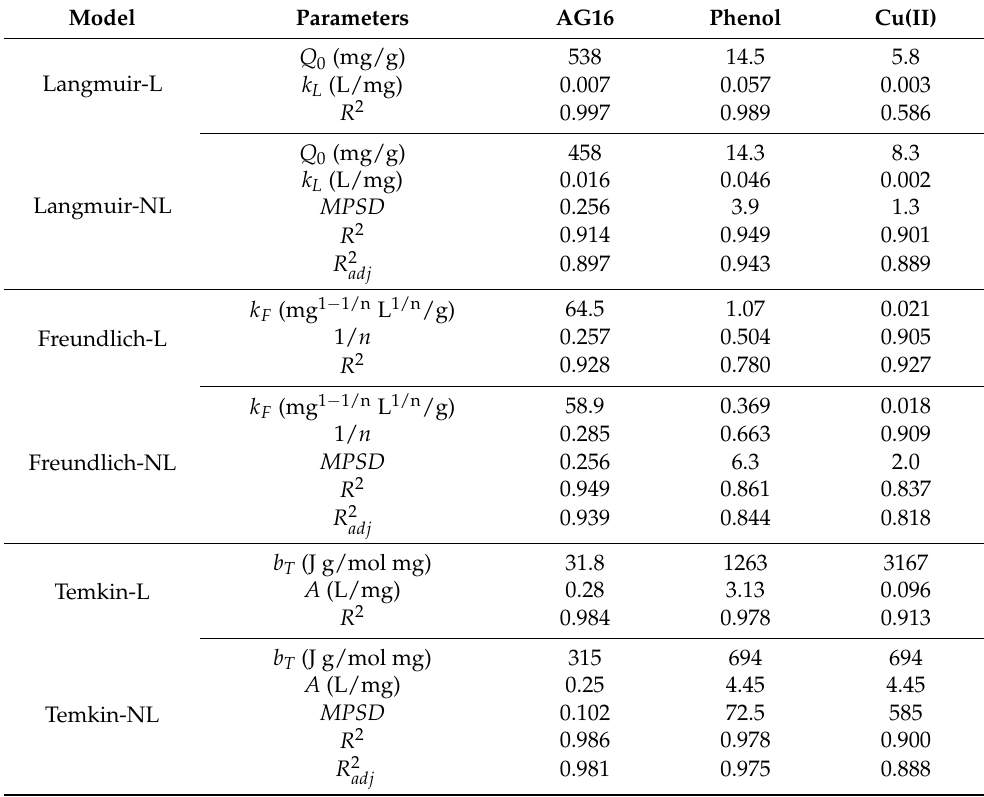
Table 1. Values of parameters of the Langmuir, Freundlich and Temkin isotherms calculated for AG16, phenol and Cu(II) sorption on S5528 anion exchange